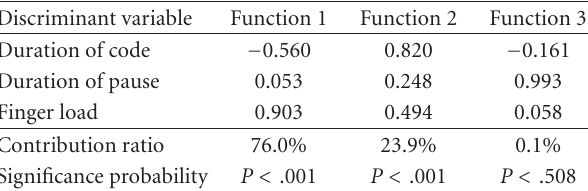
Table 3: Standardized coe ffi cients of canonical discriminant func- tions and contribution ratios (one-handed Finger